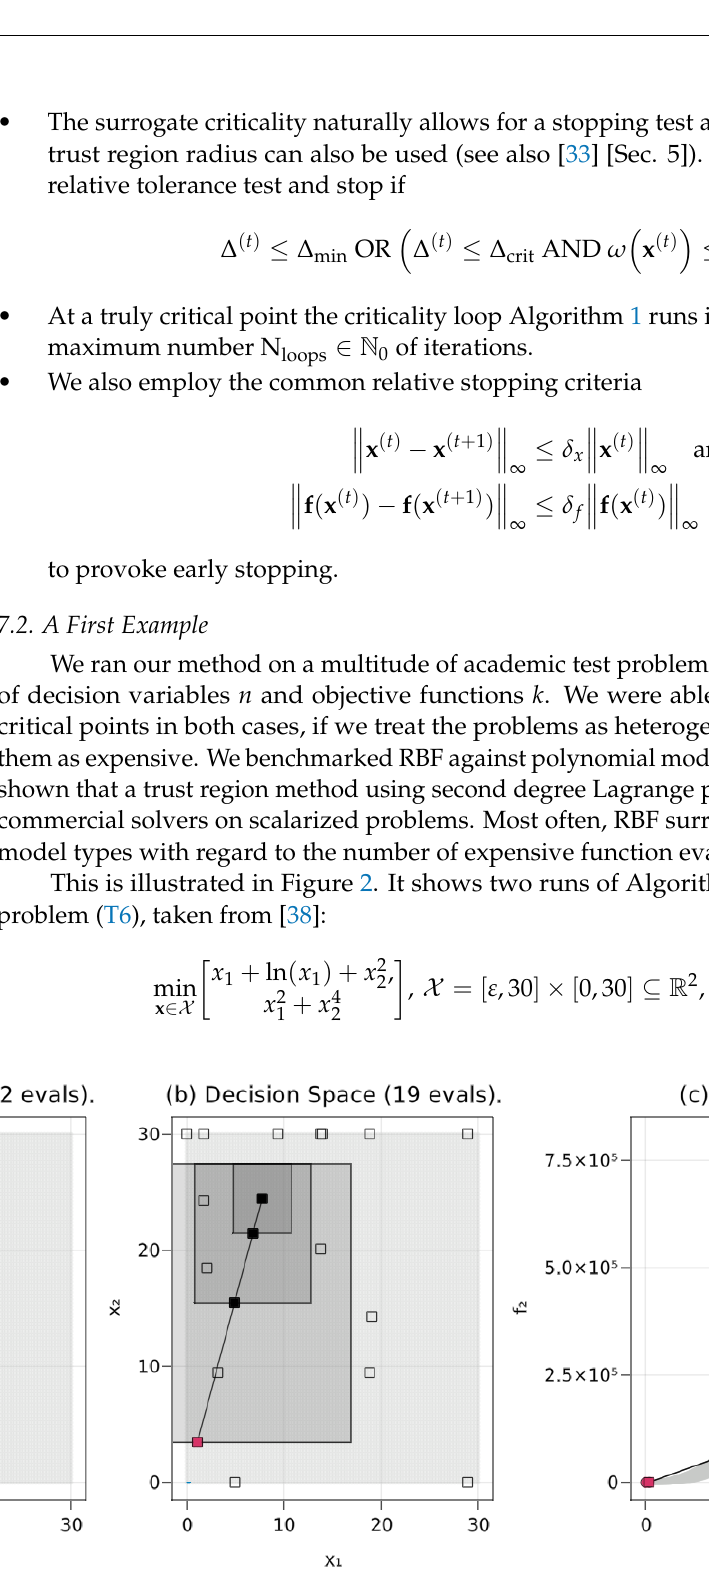
Figure 2. Two runs with maximum number of expensive evaluations set to 20 (soft limit). Test points are light-gray, the iterates are black, final iterate is red, white markers show other points where the objectives are evaluated. The successive trust regions are also shown. ( a ) Using Radial Basis Function (RBF) surrogate models we converge to the optimum using only 12 expensive evaluations. ( b ) Quadratic Lagrange models do not reach the optimum using 19 evaluations. ( c ) Iterations and test points in the objective